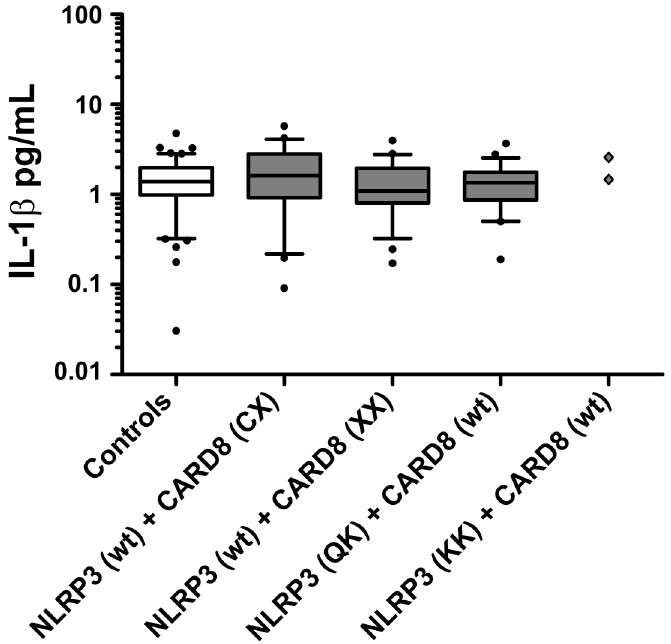
Figure 4. Basal IL-1β levels in plasma from Cases and Controls. Basal levels of IL-1β were measured by Luminex in plasma from healthy blood and plasma donors. Cases indicate individuals carrying either NLRP3 (Q705K) heterozygote (n=50) or homozygote (n=2, ◊), or CARD8 (C10X) heterozygote (n=50) or homozygote (n=47), whereas Controls are non-carriers of these polymorphisms (i.e. wild-types) (n=100). Box plots display the median value and 25 th and 75 th percentile. Whiskers represent 5-95 percentiles and dots the outliners. Data were analyzed by Mann-Whitney U-test as distribution was non-normal. doi: